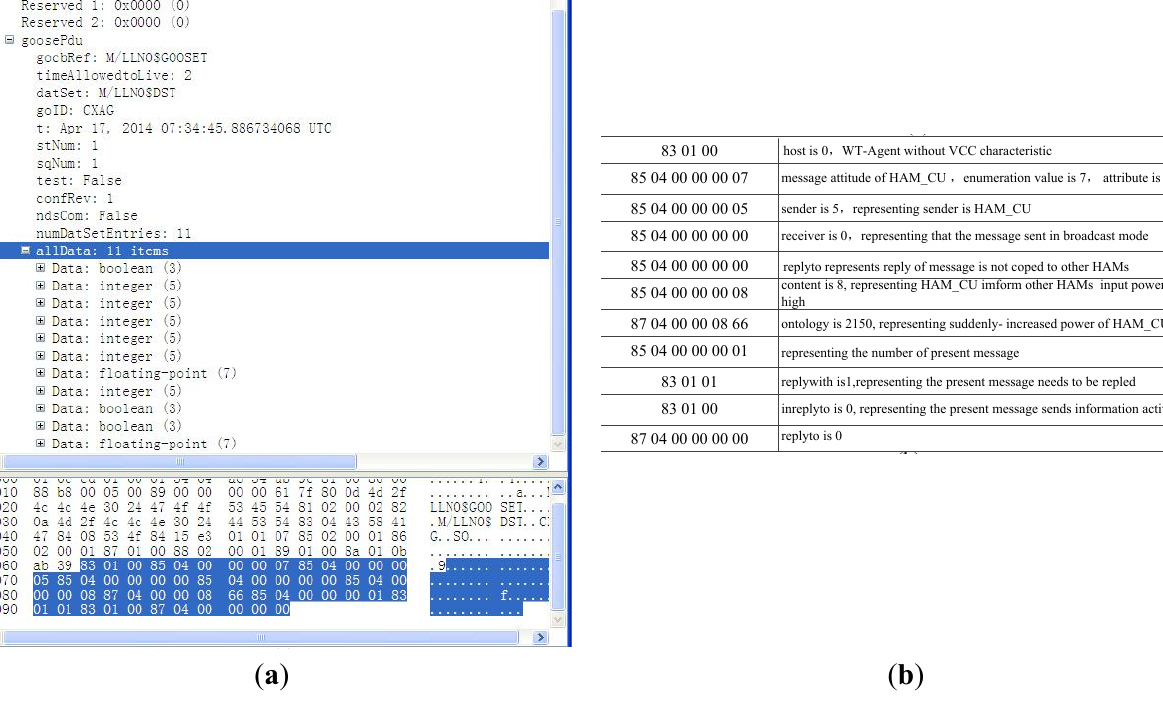
Figure A9. Inform message sent by HAM_CU in Scenario IV: ( a ) captured GOOSE message; and ( b ) illustration of data of the captured GOOSE